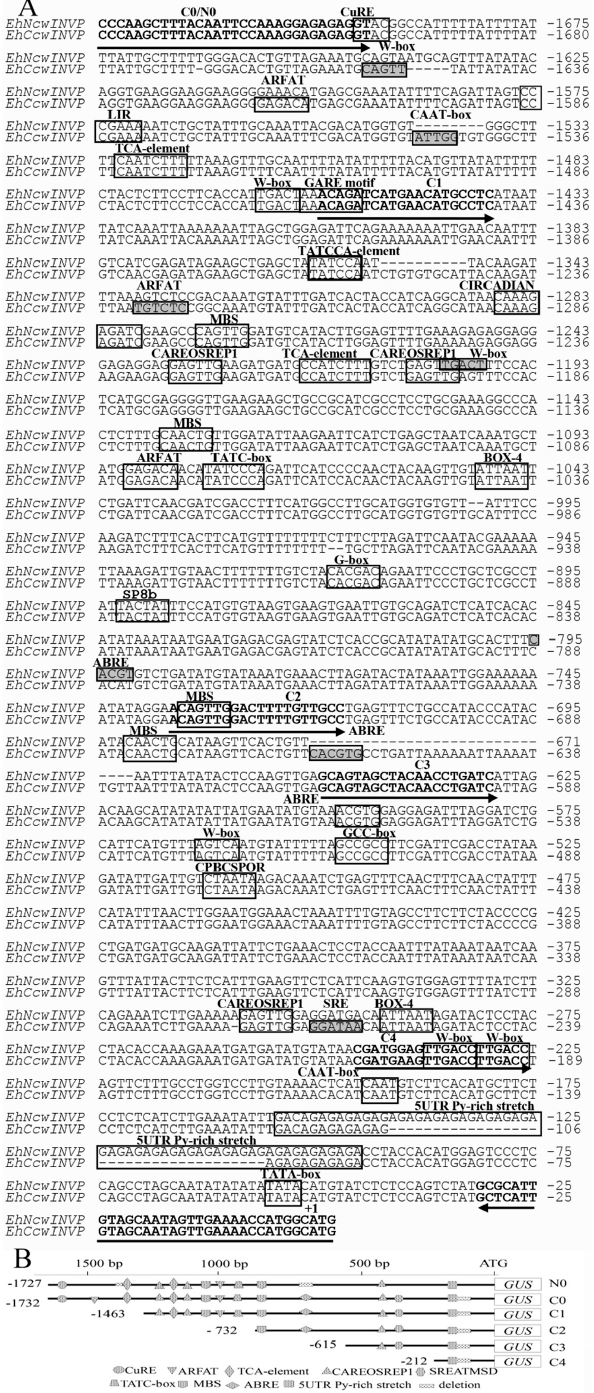
Figure 1. The putative cis elements of EhCcwINVP and EhNcwINVP ( A ) and schematic diagrams of the full-length and 5 (cid:48) -deletion CWIN promoters that drove a GUS-reporter gene ( B ). In ( A ), the cis elements are framed in boxes and labeled above. The cis elements with a gray background are unique to one promoter. The forward primers and the common reverse primer for cloning the full-length promoter and the four 5 (cid:48) -deletion promoters are in bold and are indicated by arrows. The transcription start site (ATG) is designated as +1. In ( B ), the shaded shapes represent promoter cis elements. N0 and C0 are GUS fusion constructs with the full-length promoters from non-tolerant and Cu-tolerant populations, respectively. C1, C2, C3, and C4 are 5 (cid:48) -deletion GUS fusion constructs of the promoter from the Cu-tolerant